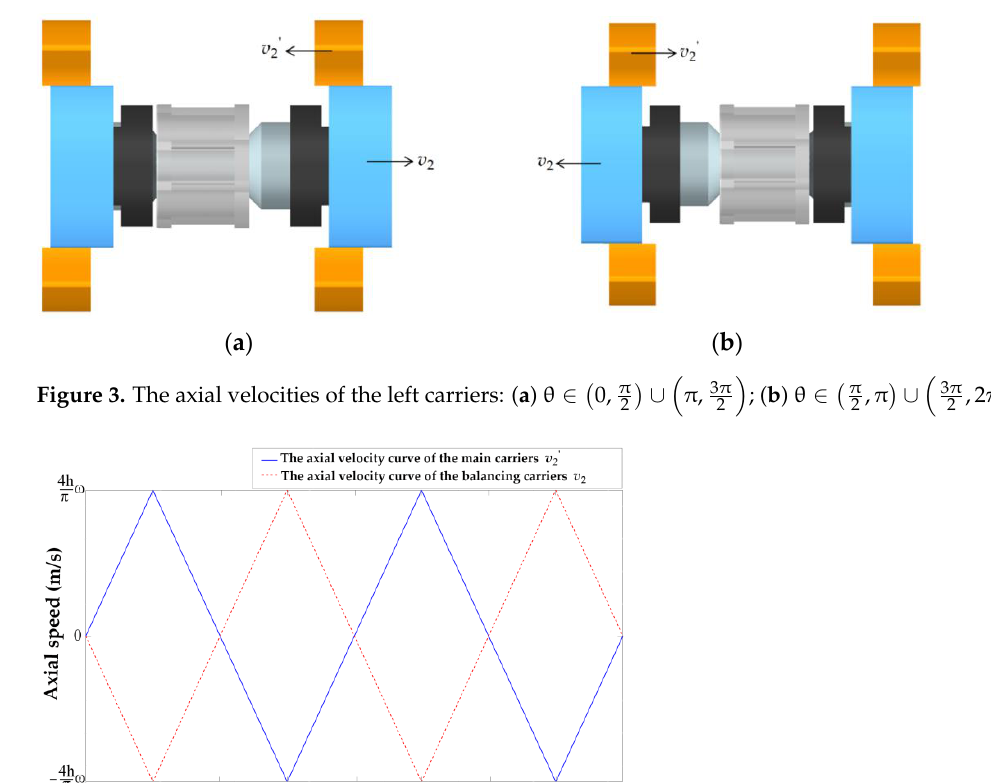
Machines 2022 , 10 , x FOR PEER REVIEW 4 of 24 Figure 2. Schematic configuration of the pump transmission sets: ( a ) main piston transmission set; ( b ) annular piston transmission set. Both the two transmission assemblies ’ rotation speeds are in accord with the input rotational velocity. The carrier’s max linear velocity 𝑣 1 is illustrated in Equation (1). Owing to the cam s’ curves, which are designed by the law of uniform acceleration and deceleration, the transmission s’ reciprocating speeds are also under this rule corre- spondingly. The axial reciprocating velocities of the main carriers and balancing carriers on either side are equal in magnitude and opposite in direction ( v 2 ’ = − v 2 ), as described by Equation (2) and shown in Figures 3 and 4. So, the annular piston transmission set can not only increase its displacement by doubling the piston stroke, but also counteract the